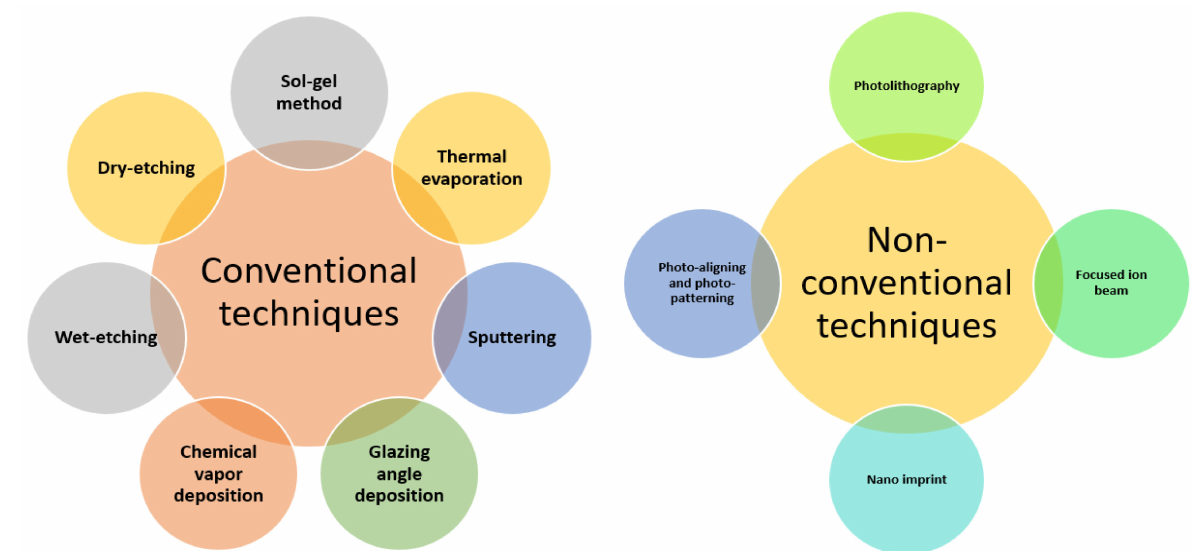
Figure 7. Classification of commonly used ARC fabrication techniques.